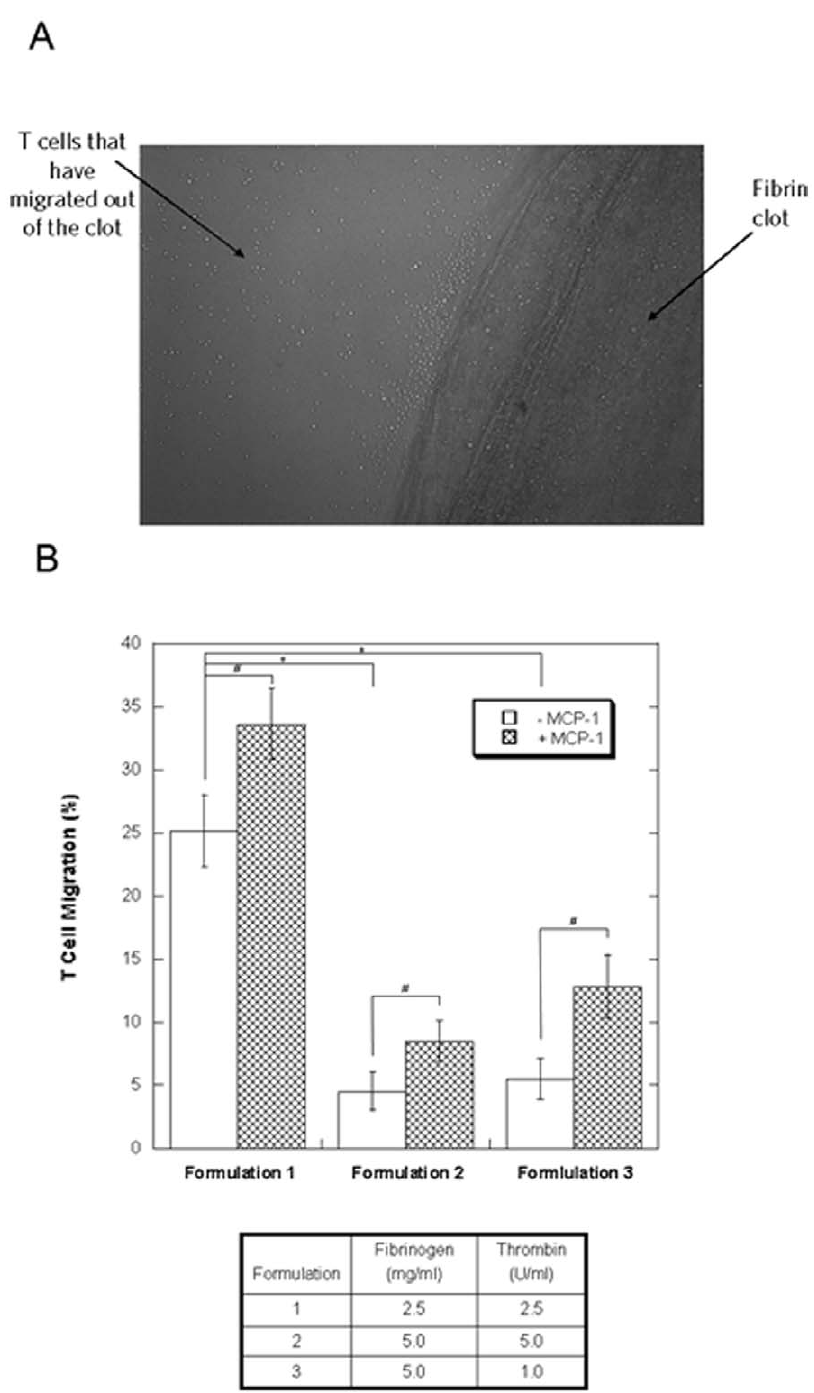
Figure 1. Effects of fibrin clot formulation and MCP-1 on T cell migration. (A) Microscopic evaluation (10 6 ) of T cell migration out of fibrin matrix. 7.5 6 10 5 T cells were mixed into a fibrin clot (Formulation 1). Substantial egress of T cells into surrounding media was visualized at 48 hours. (B) Effects of formulation and MCP-1 on CTL migration. CTLs were added to Tisseel clots with varying concentrations of thrombin and fibrinogen (Formulation 1–3). After 48 hours, ATP assays were performed to quantify the amount of CTLs able to migrate out of the clots and into the surrounding media. The matrix with the lowest viscosity (Formulation 1) allowed for the most T cell migration (* p , 0.01). In addition to viscosity, effects of MCP-1 on migration were examined. For all formulations, the addition of MCP-1 to the surrounding media significantly increased T cell migration out of the clot ( # p , 0.01). The data represents the means 6 SD of three independent experiments.